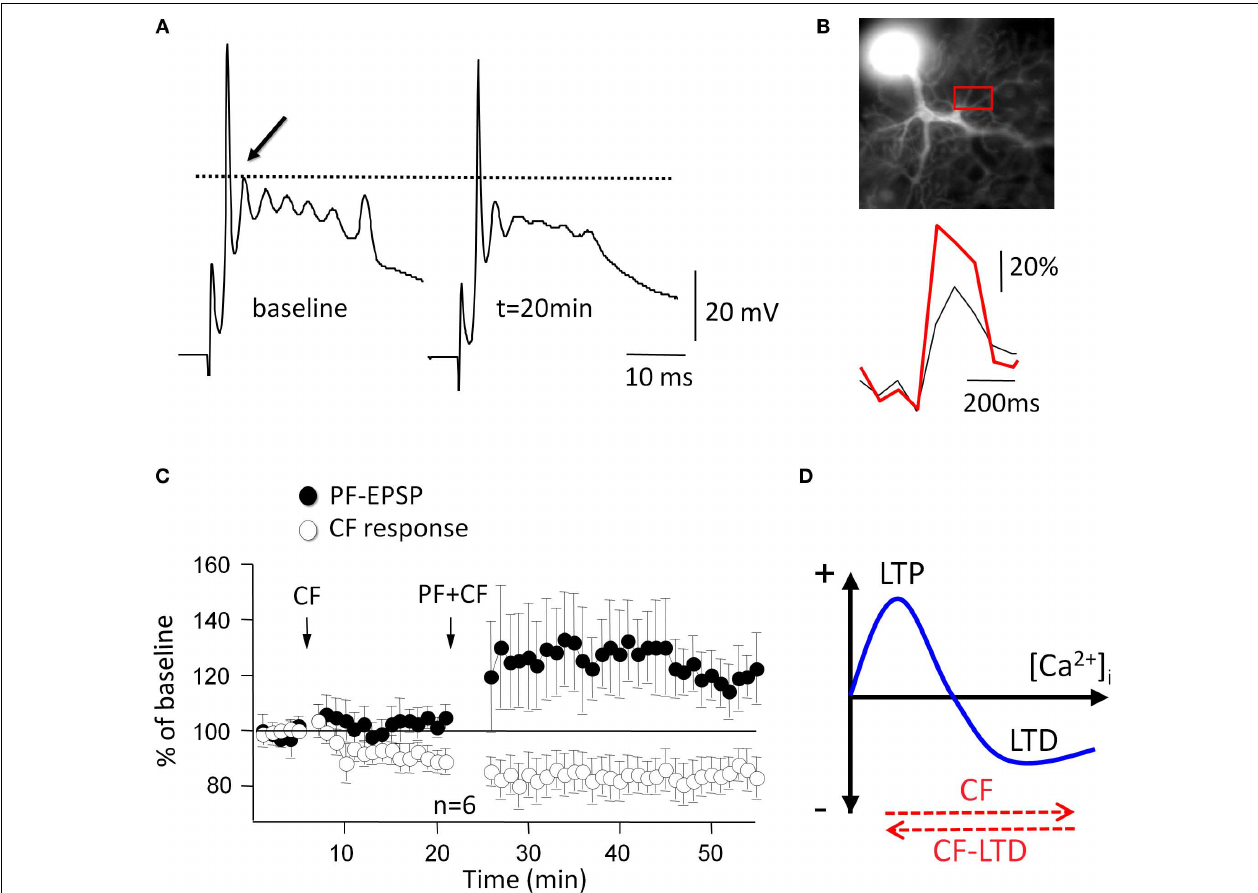
FIGURE 3 | Climbing fi ber LTD affects bidirectional parallel fi ber plasticity. (A) A 5-Hz climbing fi ber tetanization for 30 s evokes climbing fi ber LTD, which is monitored here as a reduction in the amplitude of the fi rst slow spike component (arrow). (B) Climbing fi ber LTD is accompanied by a reduction in complex spike-associated calcium transients (red trace: before climbing fi ber tetanization). Calcium transients were recorded in the region of interest (red box). Fluorescence signals were monitored using a cooled CCD camera (Quantix, Roper Scientifi c), and the calcium indicator dye Oregon Green BAPTA-2 (200 µM). (C) After induction of climbing fi ber LTD (open dots; CF